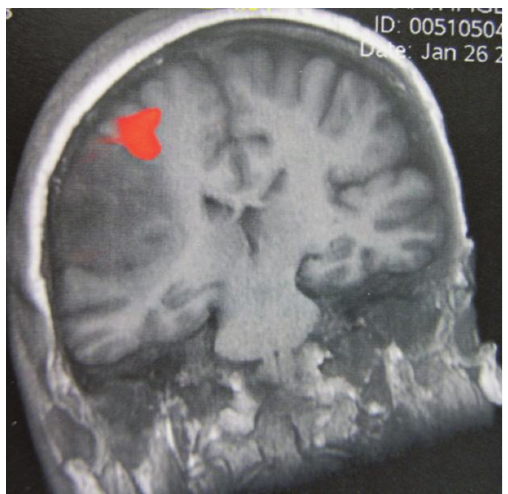
Figure 1: fMRI showing right hand activation antero-superiorly to the